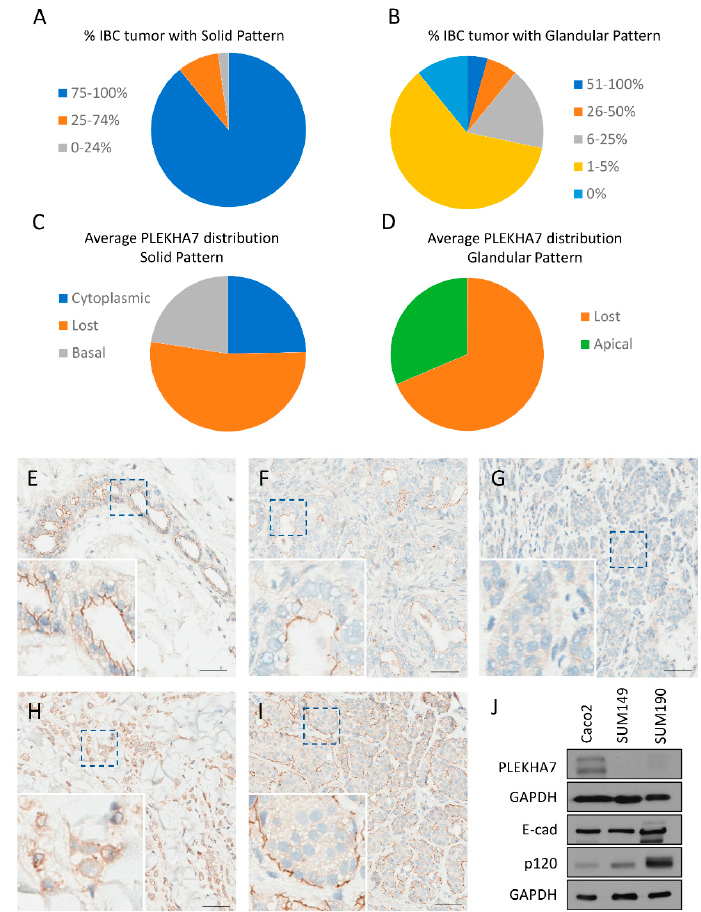
Figure 1. PLEKHA7 expression in inflammatory breast cancer (IBC) patient samples and cell lines. ( A ) Pie chart displaying the number of IBC patient samples demonstrating solid tumor patterns in 0–24% (N = 1 tumor), 25–74% (N = 4 tumors), or 75–100% (N = 41 tumors) of the total tumor. ( B ) Pie chart displaying the number of IBC patient samples demonstrating glandular tumor patterns in 0% (N = 5 tumors), 1–5% (N = 28 tumors), 6–25% (N = 8 tumors), 26–50% (N = 3 tumors), or 51–100% (N = 2 tumors) of the total tumor. ( C ) Pie chart depicting the average percentage of PLEKHA7 expression as lost (56.4%), cytoplasmic (26.4%), or basal (24.1%) in the regions of solid tumor from all IBC patient samples. No apical staining of PLEKHA7 was observed in areas of solid tumor. Note that total percentage is 106.9% since some tumor cells demonstrated both a cytoplasmic and basal staining pattern. ( D ) Pie chart depicting the average percentage of PLEKHA7 expression as lost (68.6%) or apical (31.4%) in the regions of glandular tumor from all IBC patient samples. No cytoplasmic or basal staining of PLEKHA7 was observed in areas of glandular tumor. ( E ) Expression of PLEKHA7 by immunohistochemistry (IHC) in normal breast tissue. Scale bar = 100 µ m in all images. ( F – I ) Examples of expression patterns for PLEKHA7 in IBC patient samples. ( F ) Apical staining, ( G ) loss of staining, ( H ) cytoplasmic staining, and ( I ) basal staining. ( J ) A representative gel image demonstrating expression of PLEKHA7, E-cadherin, and p120-catenin by Western blot is